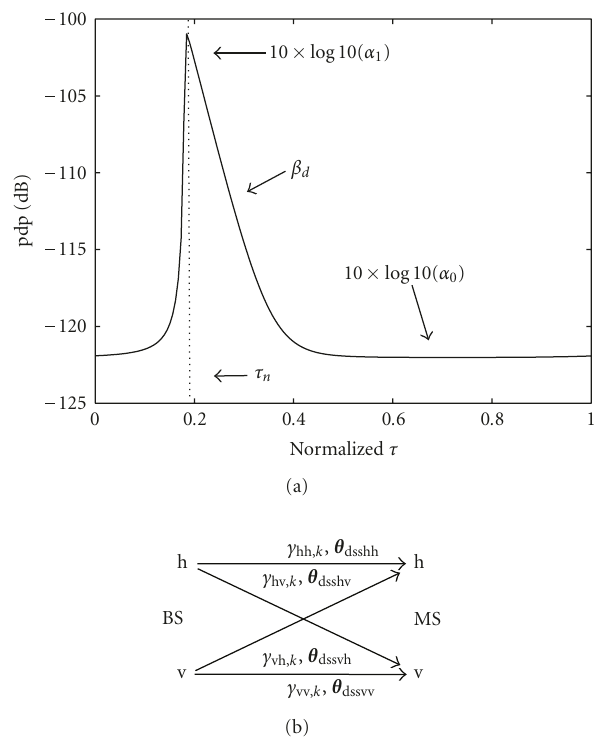
Figure 1: Model of the DMC (a), SC polarization and DMC polar- ization schematic